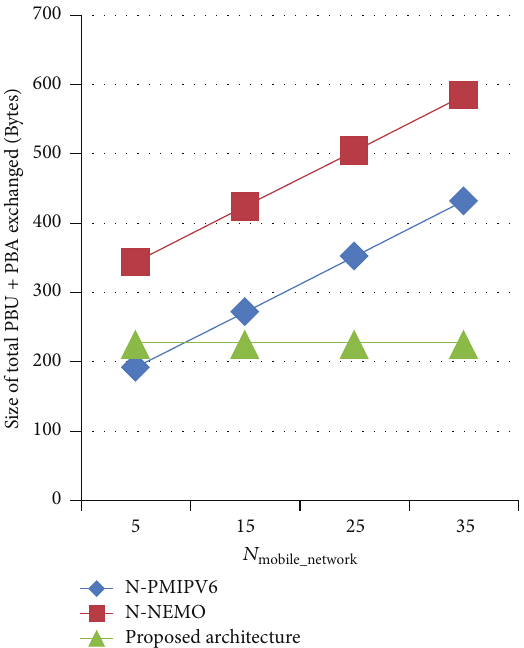
Figure 10: Analysis on signaling cost while varying 𝑁 mobile network .